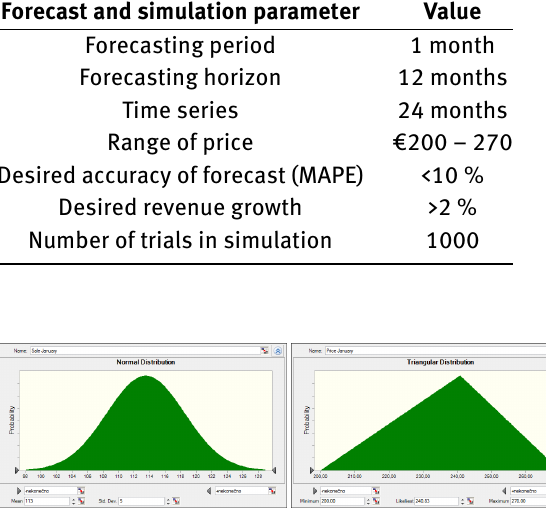
Forecast and simulation parameter